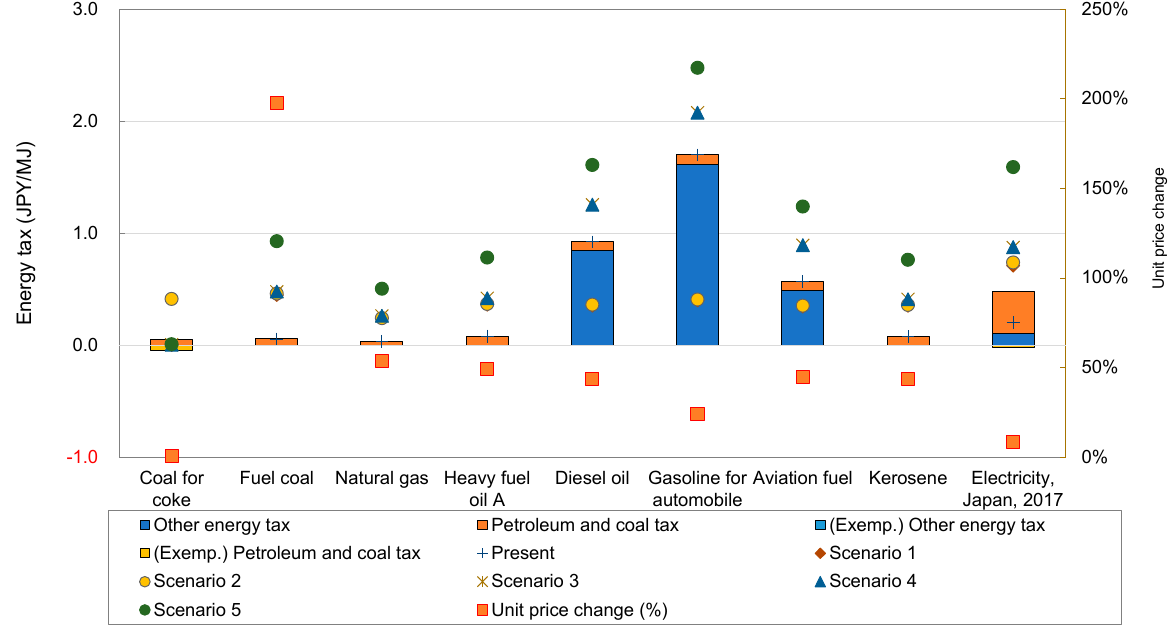
Figure 3. Changes in product taxes and product prices in livestock under different taxation scenarios. The bar graphs show the present taxation breakdown. The percentage change in product prices compares the present with Scenario 5.